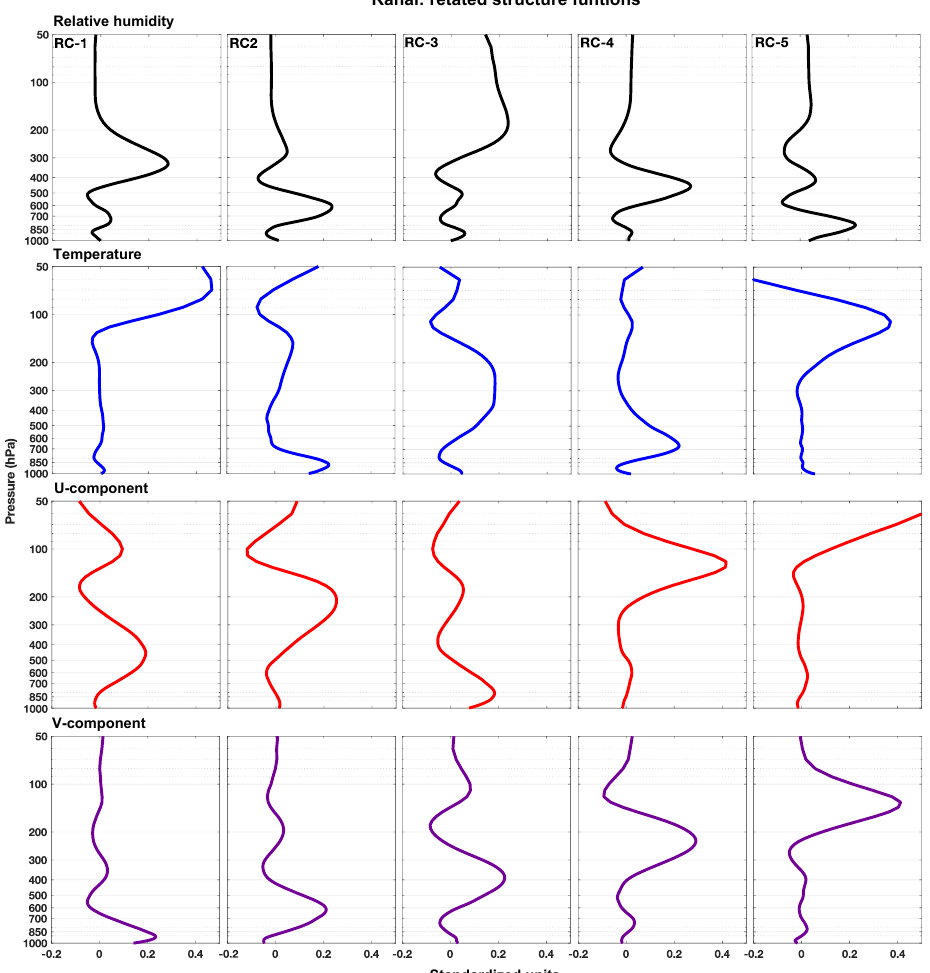
Figure 8. The first five RCs at the Ranai upper-air sounding site for relative humidity (black), temperature (blue), u component (red), and v component (purple). The y axis is in log-pressure (hPa) and the x axis is in standardized units. For simplification, only one sign of the eigenvectors is included in this